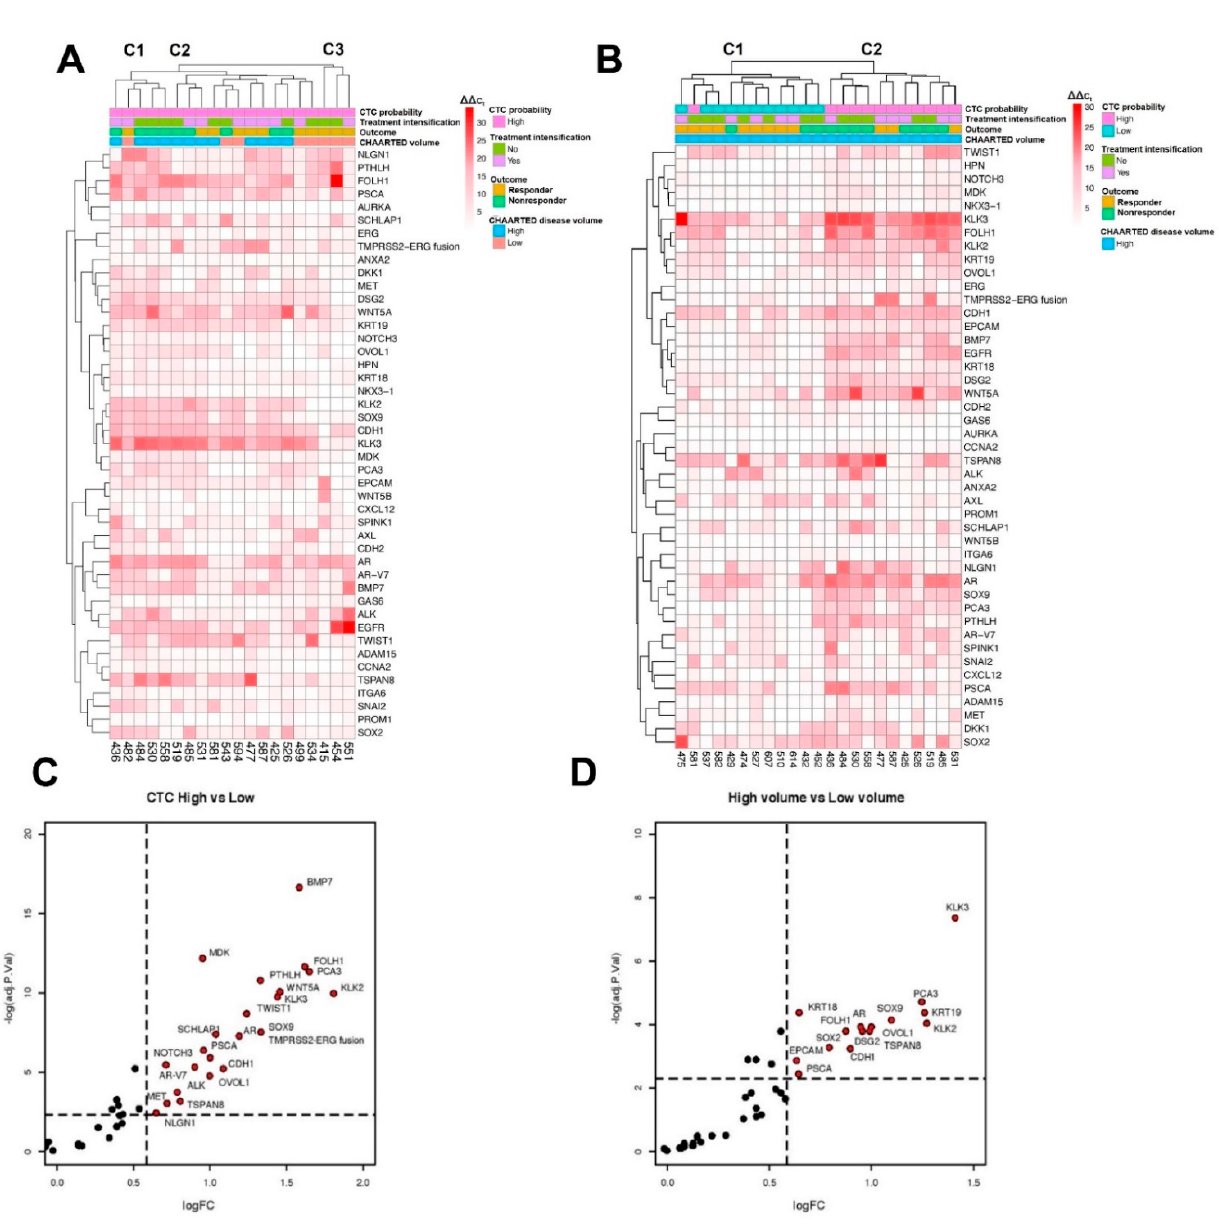
Figure 2. Unsupervised clustering of CTC high patient ( A ) and HV patient ( B ) samples. Patient characteristics, including treatment intensification and CHAARTED volume, and patient outcomes (responder/nonresponder) are annotated above the heatmap, and deidentified patient ID numbers and interrogated genes are annotated on the bottom and right of the heatmap, respectively. Volcano plots showing differentially expressed genes based on CTC prevalence ( C ) and CHAARTED volume ( D ). Genes that passed FDR < 10% and LogFC > 0.585 cut-offs were determined significant and are highlighted on the plot.